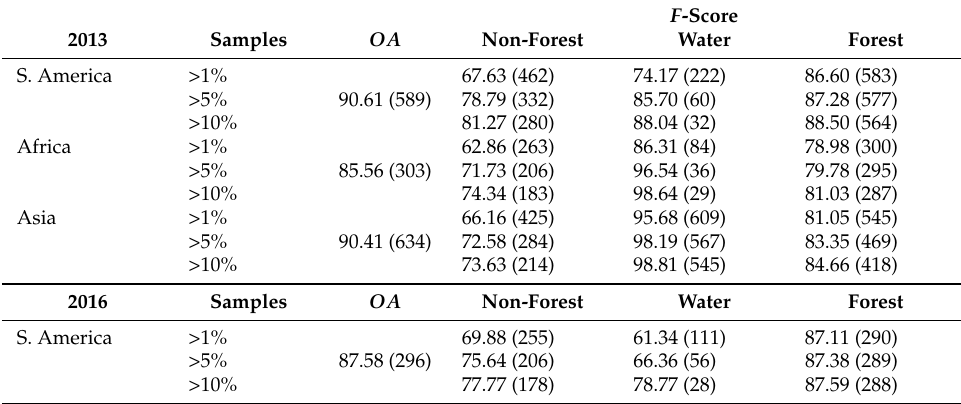
Table 3. Performance comparison between TanDEM-X mosaics and FROM-GLC. For an explanation of each field, please refer to the caption of Table